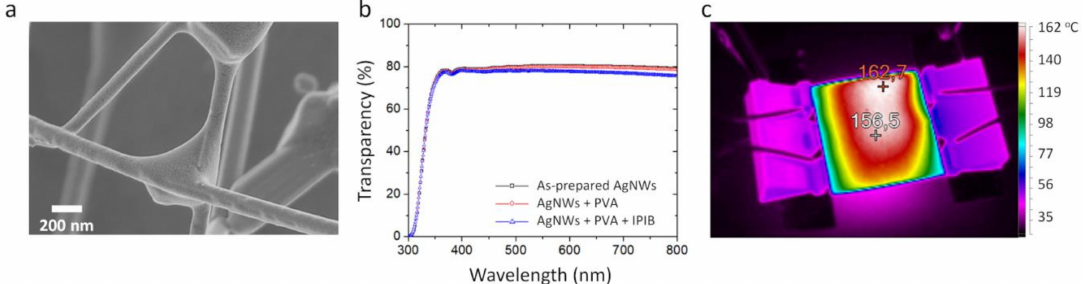
Figure 3. Intense pulsed ion beam (IPIB) modified transparent conductive coating (TCC) covered with poly-vinyl alcohol protective layer ( a ). SEM image of irradiated TCC, ( b ) transmittance spectra of TCC before and after irradiation by IPIB. ( c ) IR-image of TCC based